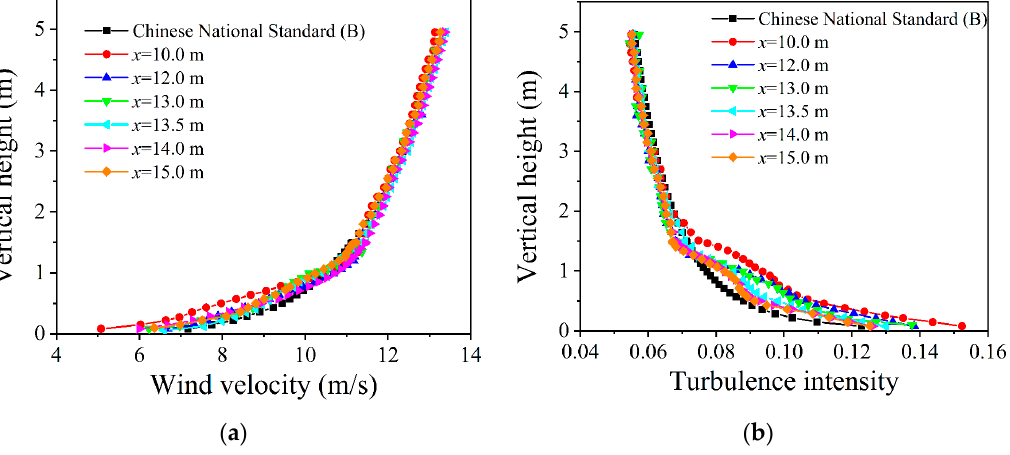
Figure 6. Wind velocity and turbulence intensity profiles at different x positions on the central axis of the model region: ( a ) Wind velocity profile; ( b ) Turbulence intensity profile.